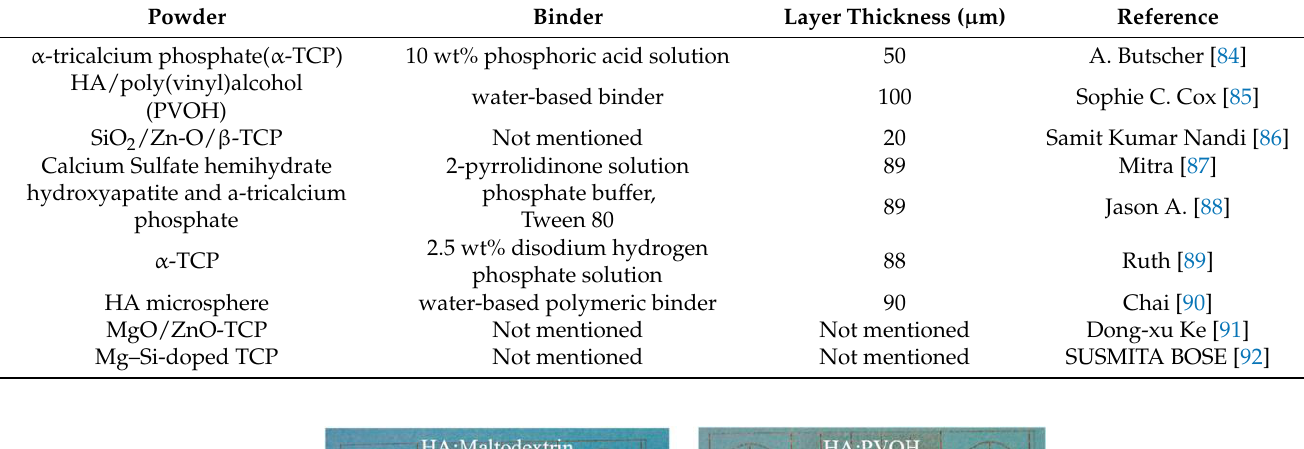
Table 2. Examples of porous implants for bone tissue regeneration that have been used in recent research on binder jet 3D printing.